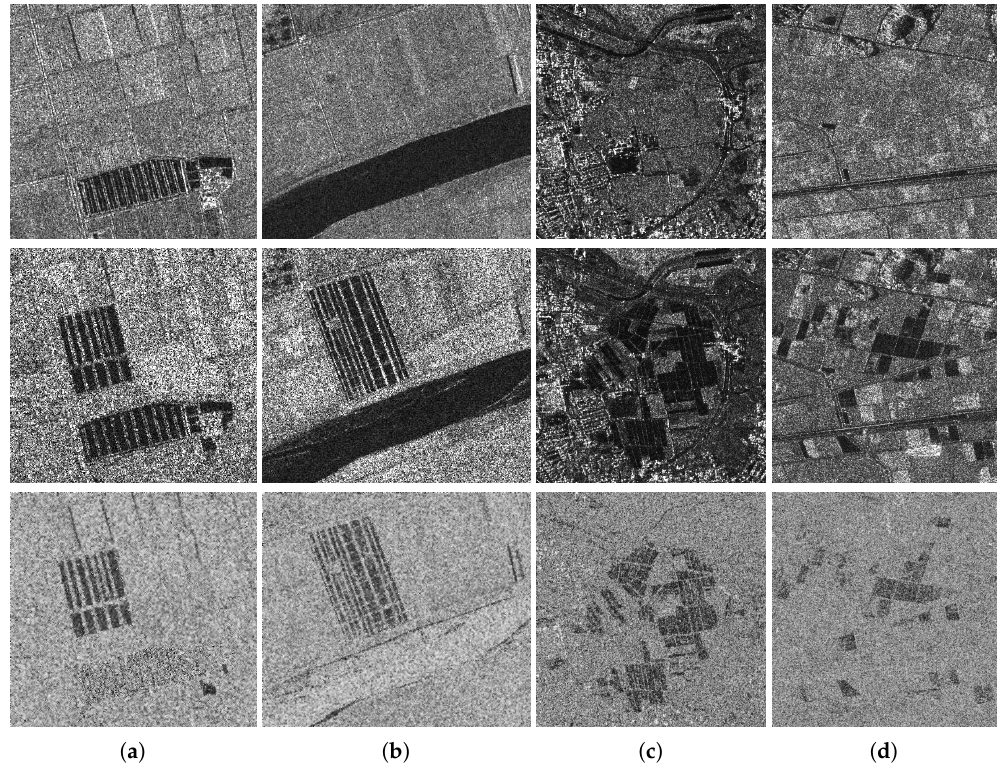
Figure 2. Four sets of bitemporal synthetic aperture radar (SAR) images: ( a ) YR-A, ( b ) YR-B, ( c ) Sendai-A, and ( d ) Sendai-B. The images in first two rows are bitemporal SAR images and the last row are the difference images